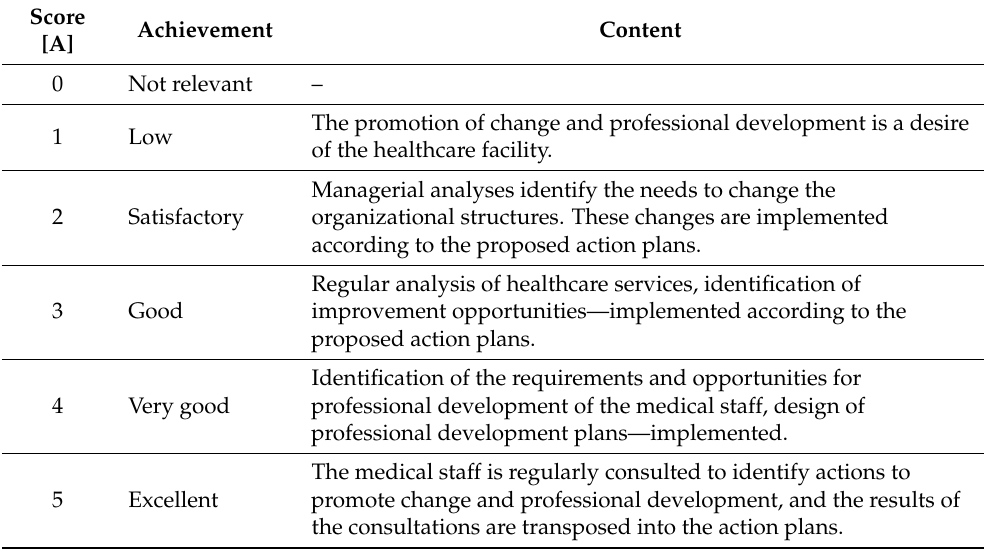
Table A2. Scale for indicator PA3—Promotion of change and professional development.